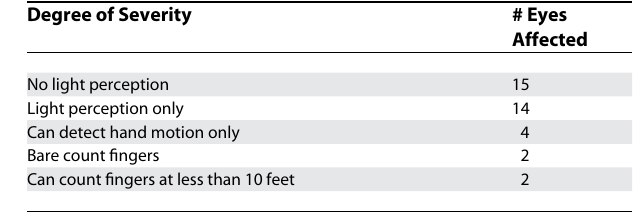
Blindness was defined according to WHO criteria of less than 3/60 visual acuity. Average age of the patients was 37 years.